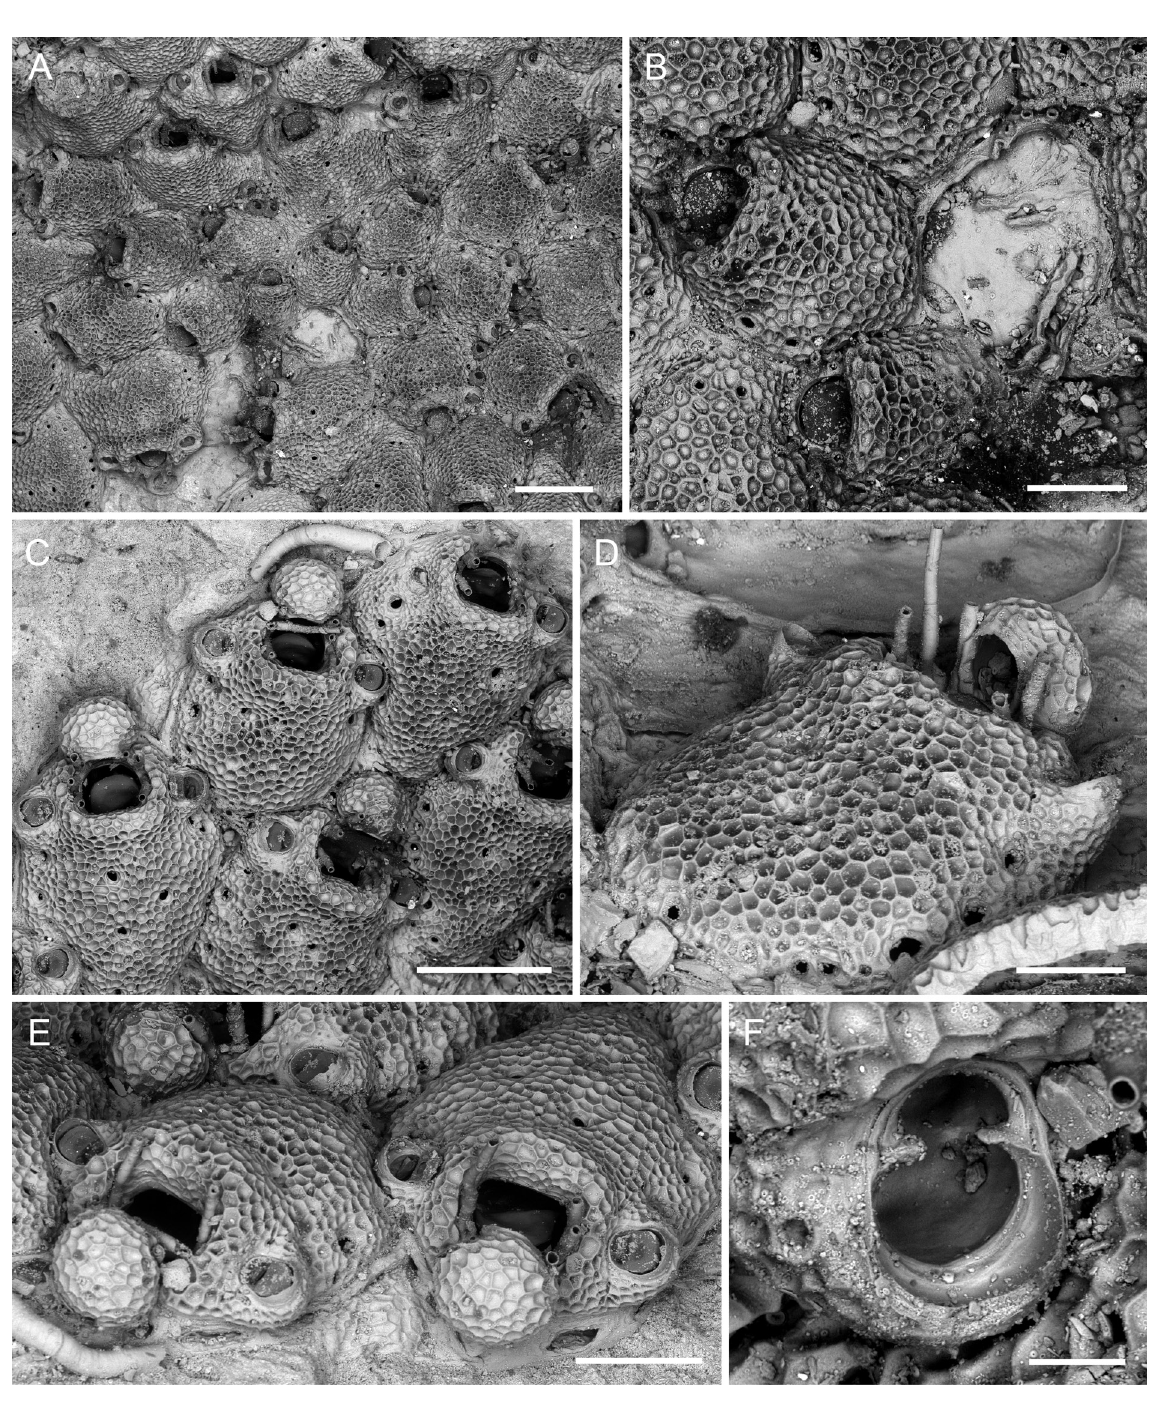
Fig. 13. Calvetopora inflata (Calvet, 1906) gen. et comb. nov., Gulf of Cádiz, holotype (MNHN- IB-2008-2470). A . Overview of the periancestrular part of the colony. B . Close-up of the ancestrula and the first two autozooids. C . Maternal autozooids at the colony growth margin. D . Lateral view of an ovicellate zooid. E . Distal view of the colony growth margin showing the kenozooidal origin of the ooecia. F . Close-up of an avicularium. Scale bars: A, C = 500 µm; B, D = 200 µm; E = 300 µm; F = 50